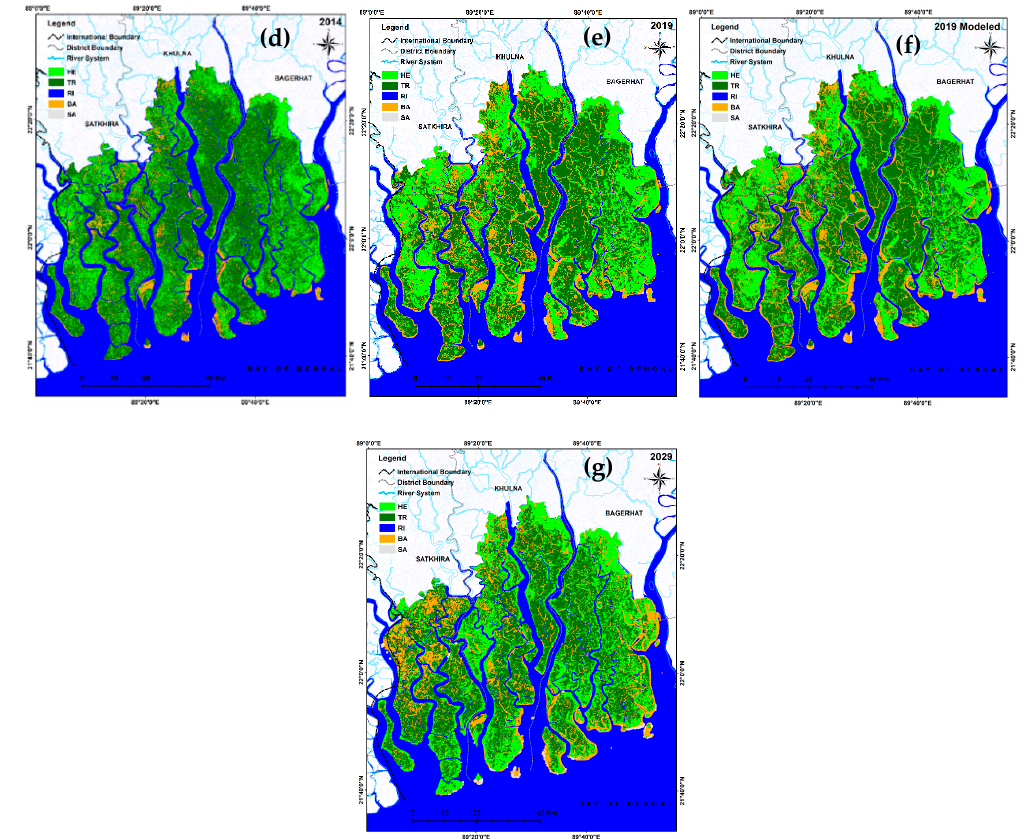
Figure 5. Changes in LC status of the SRF (1989 to 2029). ( a ) LC in 1989; ( b ) LC in 1999; ( c ) LC in 2009; ( d ) LC in 2014; ( e ) LC in 2019 (actual); ( f ) LC in 2019 (simulated); ( g ) LC in 2029